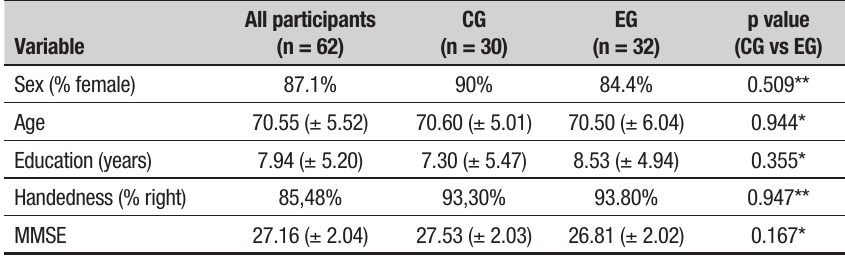
Table 1. Demographic and clinical data of participants.